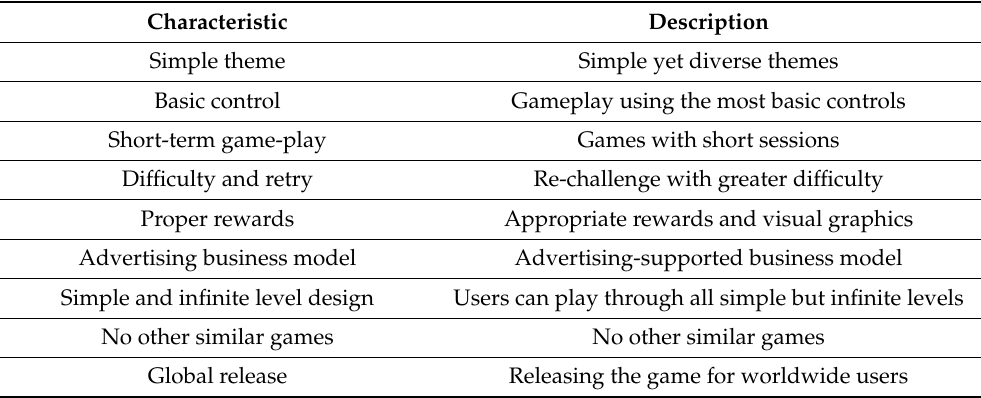
Table 2. The 10 characteristics of casual games. Characteristic Description Simple theme Simple yet diverse themes Basic control Gameplay using the most basic controls Short-term game-play Games with short sessions Difficulty and retry Re-challenge with greater difficulty Proper rewards Appropriate rewards and visual graphics Advertising business model Advertising-supported business model Simple and infinite level design Users can play through all simple but infinite levels No other similar games No other similar games Global release Releasing the game for worldwide